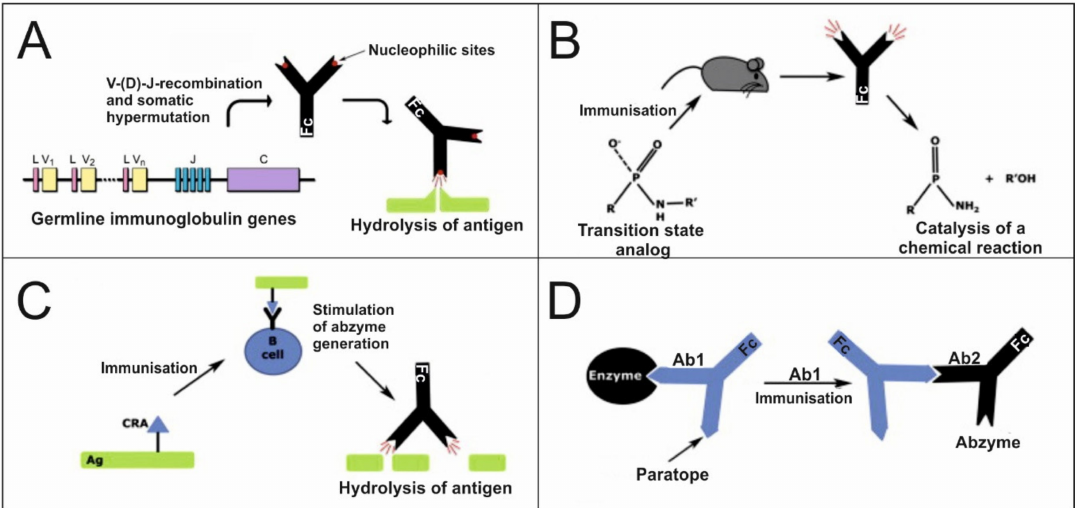
Figure 1. Various mechanisms of the formation of catalytic Abs. ( A ) Adaptive maturation of nucleophilic centers of Abs, originating from the initial germline Ig genes; ( B ) Immunization with a stable analog of the transition state of a chemical reaction; ( C ) Immunization with an antigen conjugated to a covalent reactive analog (CRA); ( D ) The formation of abzymes due to the idiotypic–anti-idiotypic interactions of Abs. Adapted with permission from Elsevier